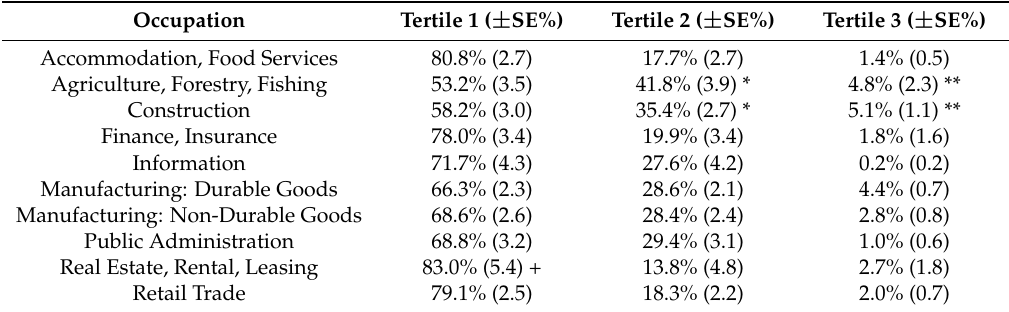
Table 6. Longest Held Occupation and Teritles of Exposure.